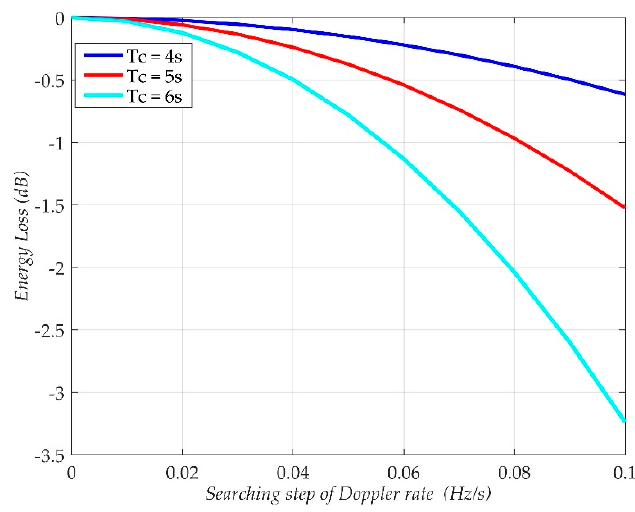
Figure 9. The impact of searching step of Doppler rate on the amplitude of the final result.